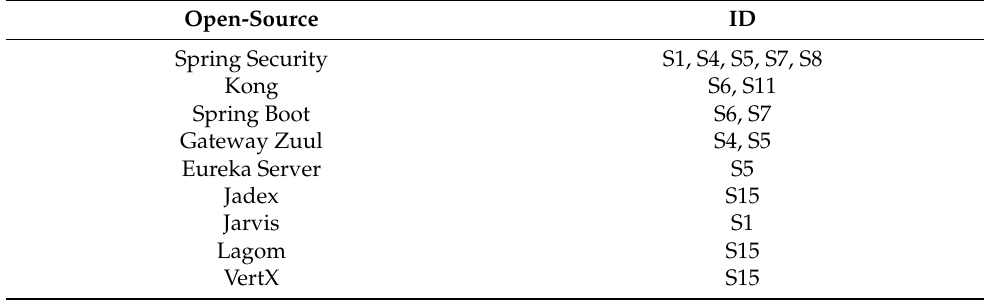
Table 6. Open-source technologies that implement security in microservices